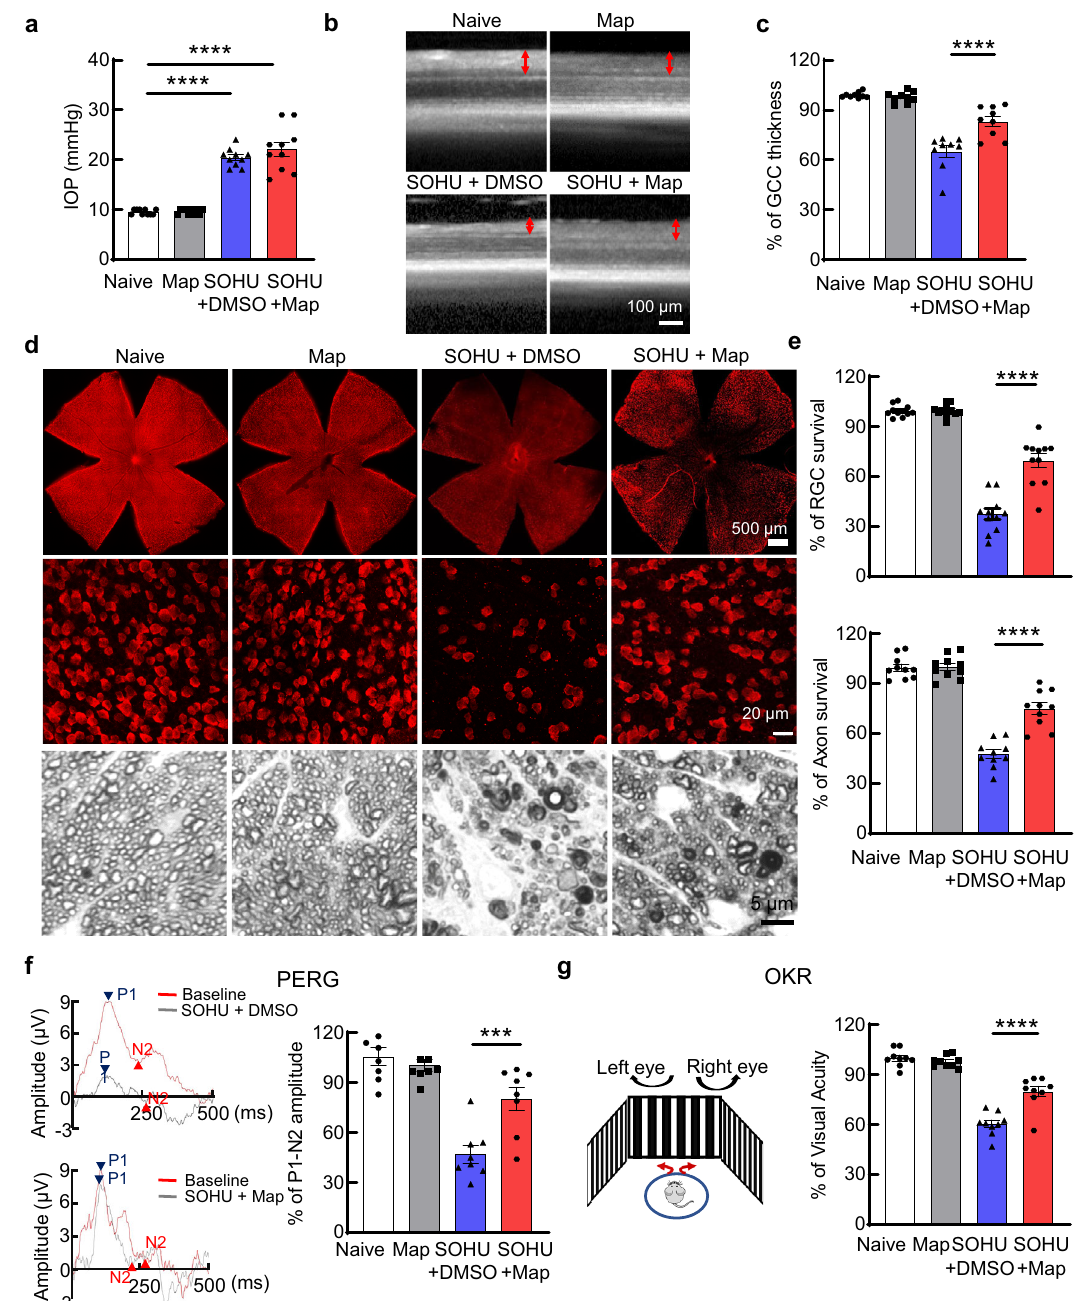
Fig. 5 | Systemic administration ofMap signi fi cantly protects RGC somata and axons and preserves visual function in a mouse glaucoma model. a IOP mea- surements at 3wpi. SOHU: intracameral injection of SO to induce ocular hyper- tension. n =10mice. b RepresentativeOCTimagesofmouseretinainlivinganimals at 3wpi. GCC is indicated as double end red arrows. c Quanti fi cation of GCC thicknessmeasuredbyOCTat3wpi,representedaspercentageofGCCthicknessin the SOHU eyes compared to the sham contralateral control eyes. n =9 mice. d Upper panel: representative confocal images of wholemounts of the entire reti- nas. Middle panel: representative confocal images of fl at-mounted peripheral retinasshowingsurvivingRBPMS+(red)RGCsat3wpi.Lowerpanel:representative lightmicroscopeimagesofsemi-thintransversesectionsofONwithPPDstainingat 3wpi. e Quanti fi cationofsurvivingRGCsomatainwholemountretinasandaxonsin ON sections at 3wpi, represented as percentage in SOHU eyes compared to the